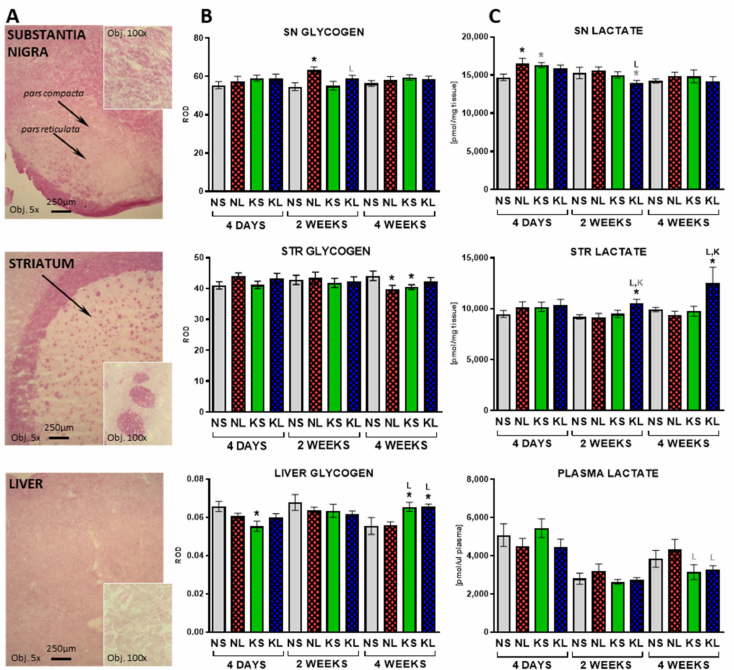
Figure 6. Glycogen was measured on stained tissue sections from SN and STR and liver ( A ) as Relative Optical Density (ROD) ( B ). Lactate ( C ) was measured in plasma and brain homogenates from dopaminergic structures SN and STR. Data are presented as mean ± SEM. Analysis was performed at time-points 4 days, 2 weeks, and 4 weeks after brain surgery. Animals were kept on ketogenic diet for 3 weeks in advance. p value ≤ 0.05 was set as significance threshold and marked as * vs. normal diet + sham (NS group), L vs. normal diet + 6-OHDA lesion (NL group), K vs. ketogenic diet + sham (KS group), KL stands for ketogenic diet + 6-OHDA lesion group. Statistical trends 0.05 < p ≤ 0.1 were marked in grey symbols. Statistics: 3-way ANOVA with LSD post hoc test. Number of animals was 5–7 per